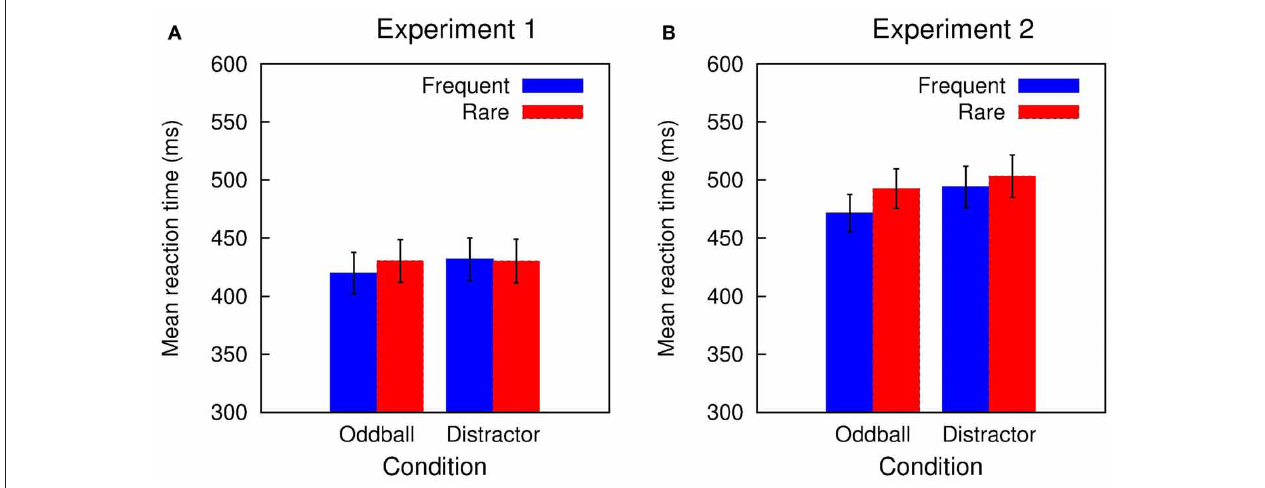
FIGURE 1 | Summary of the RT results obtained in (A) Experiment 1 and (B) Experiment 2. A small distraction effect is elicited in rare stimuli in the Distractor condition of Experiment 1. In Experiment 2, rare stimuli in both conditions resulted in RT prolongation.